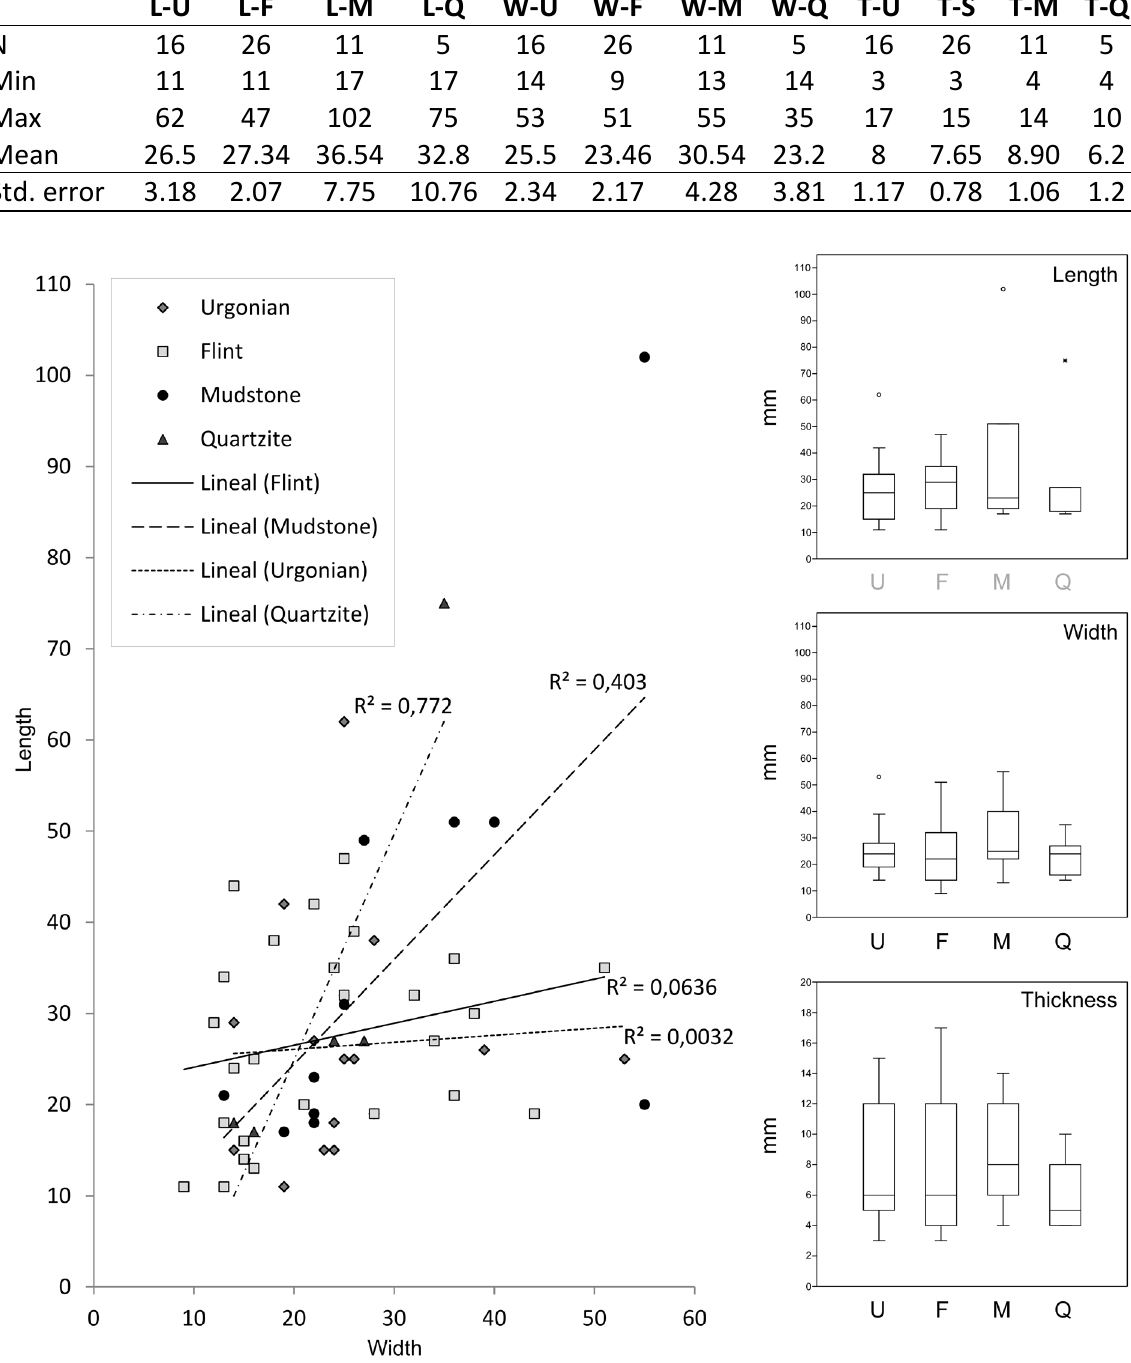
Figure 10. Metric analysis of non-broken flaked products from Ventalaperra’s level III. Abbreviations: U - Urgonian, F - flint, M - mudstone, Q -